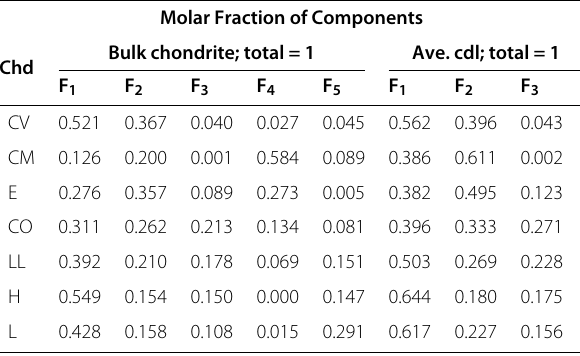
Table 5 Molar fractions of components for the bulk chondrite and for the